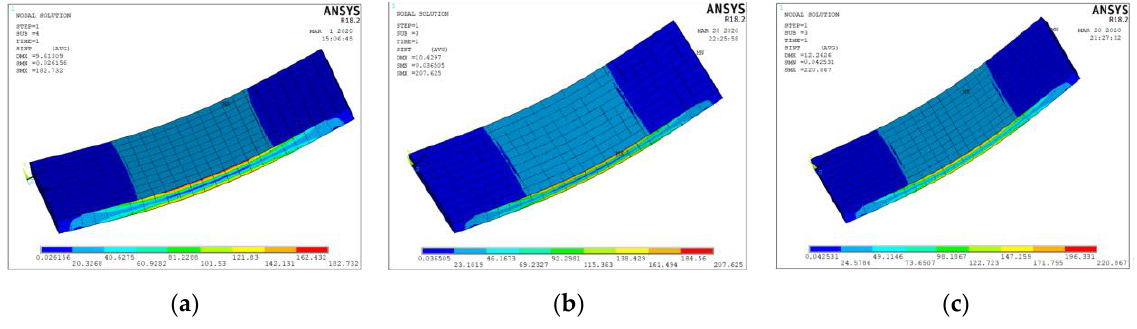
Figure 20. Stress nephogram of composite floor with di ff erent thickness: ( a ) 120, ( b ) 110 and ( c ) 100 mm.